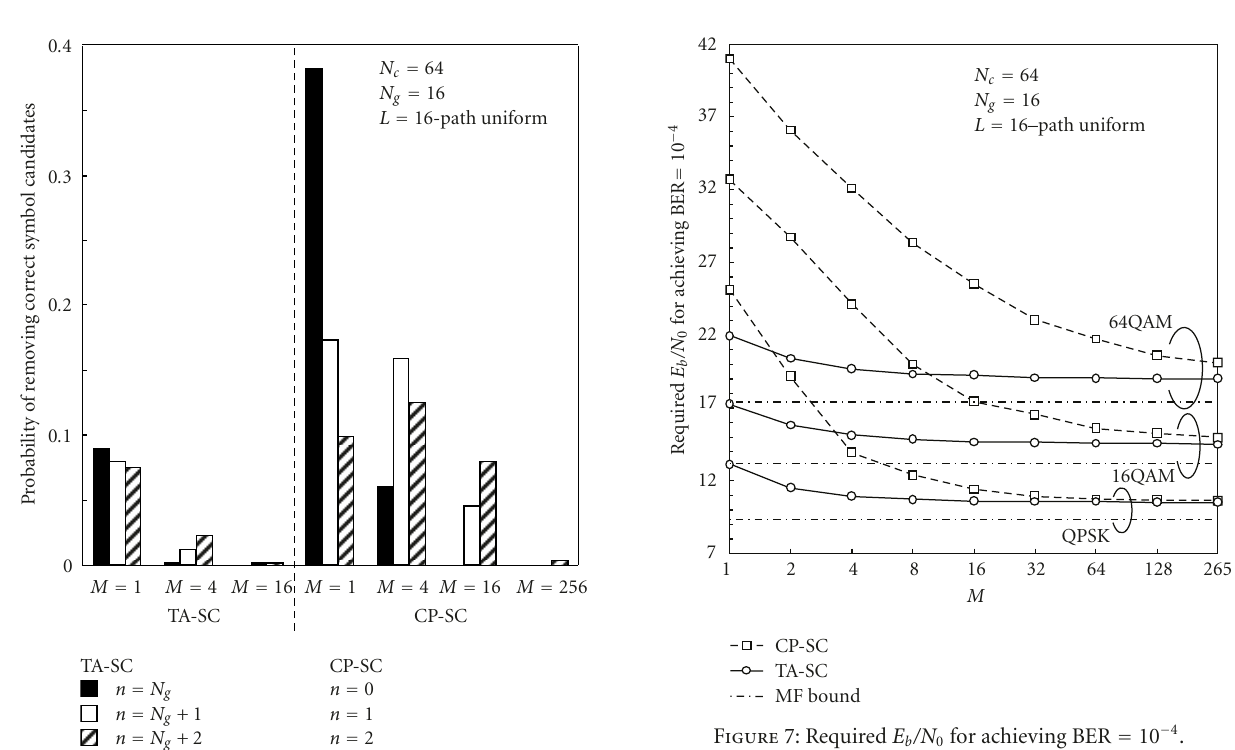
Figure 6: Probability of removing correct path at n th stage ( n = 0 ∼ 2). 16QAM.